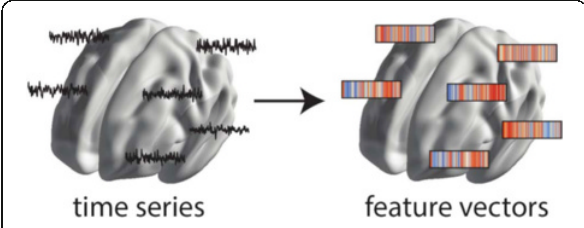
Fig. 9 (abstract A10). Illustration of the highly comparative approach to time-series data from